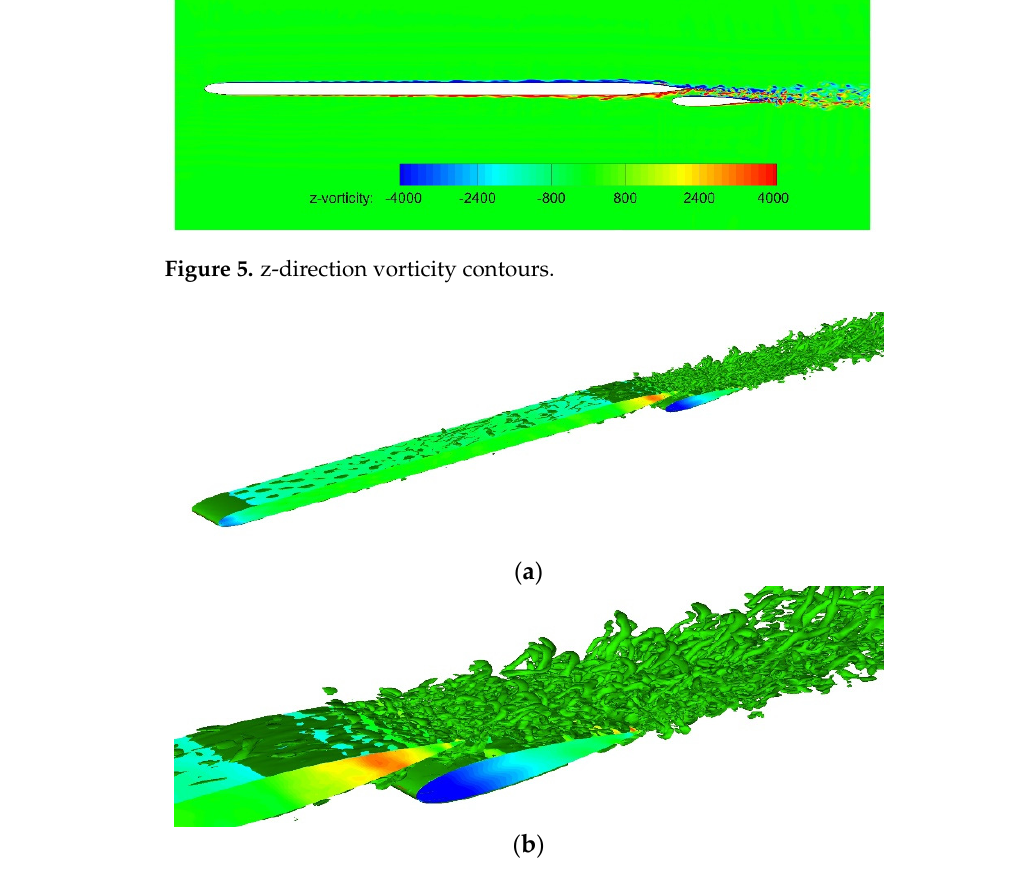
Figure 6. Iso-surfaces of Q-criterion (Q = 5000) for the case with the deflection angle of 0°: ( a ) the whole view; ( b ) zoom-in view near the flap.